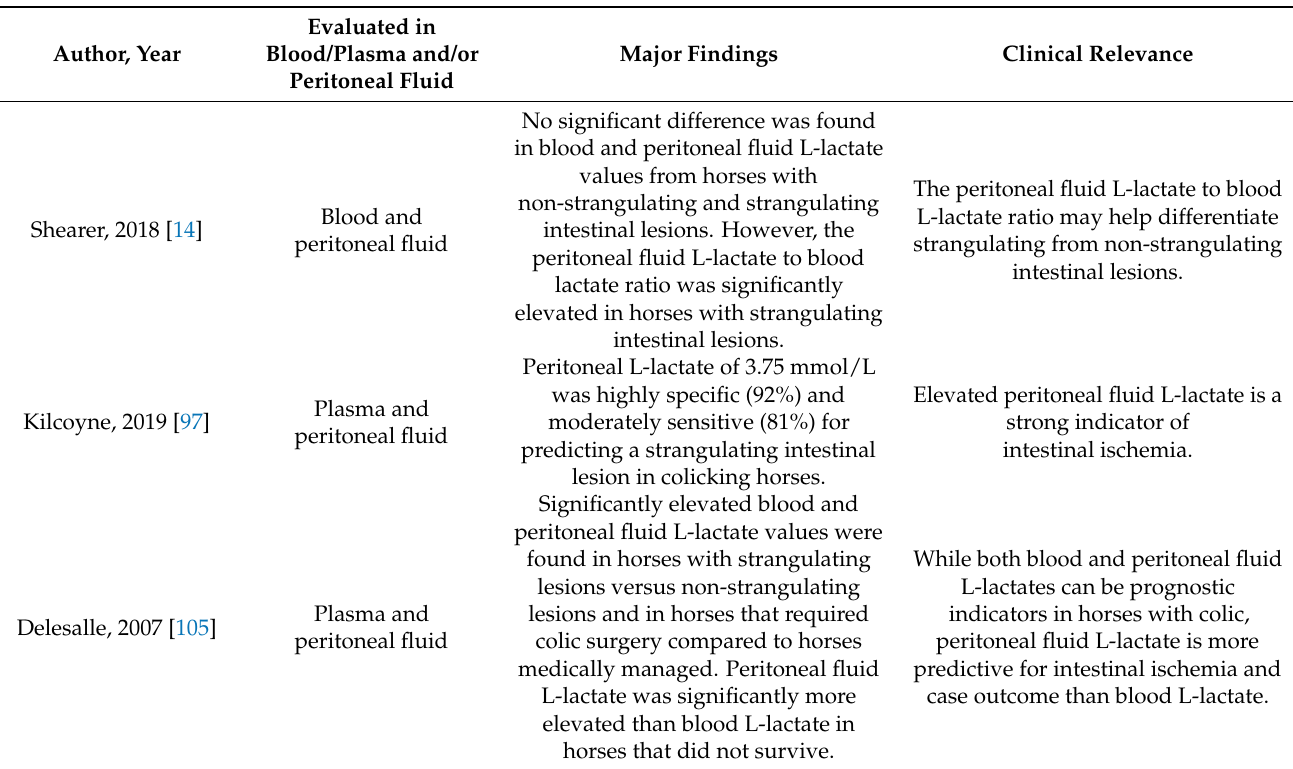
Table 2. Summary of five original research papers describing the use of L-lactate in the equine patient with